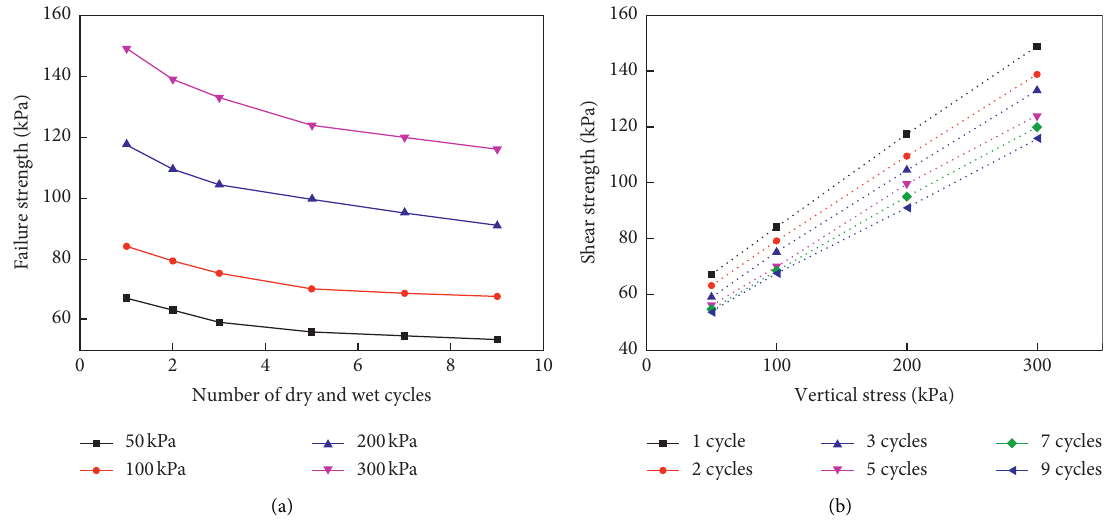
Figure 5: Failure strength curve and shear strength line of red clay under different dry and wet cycles (wet for 4h).